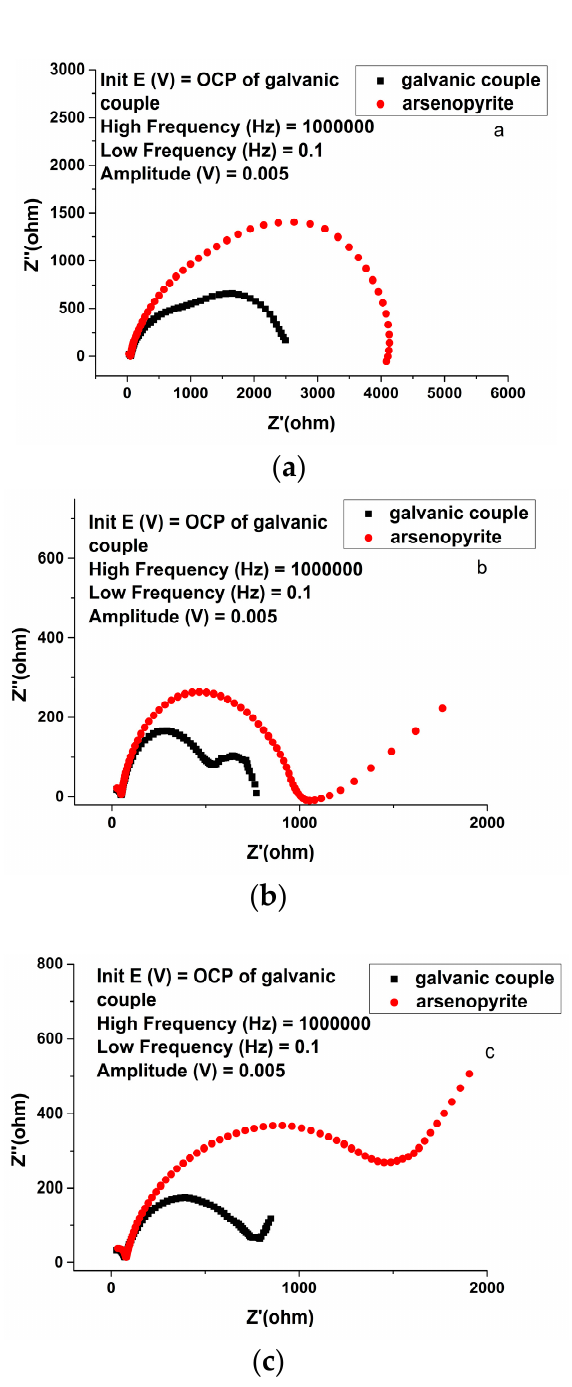
Figure 5. Nyquist plots of the galvanic pair and arsenopyrite in sulfuric acid ( a ), ferric ion ( b ), and